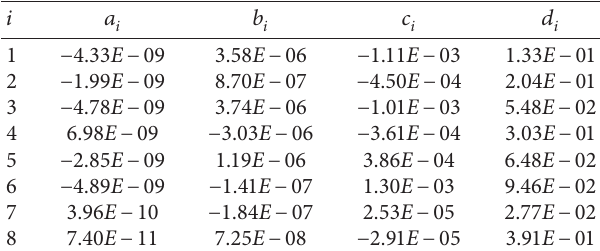
Figure 9: Model optimization: (a) quasistatic error and (b) regression coefficient of the static pressure model. Table 1: Identified parameters of the static pressure